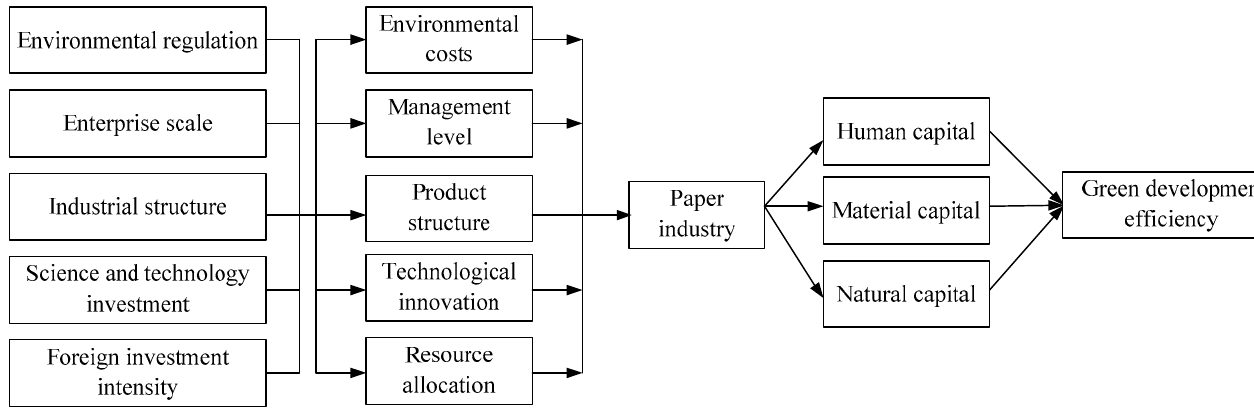
Figure 1. Analysis framework of green development efficiency of the paper industry.